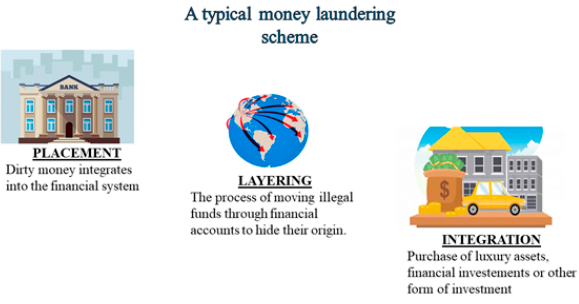
Figure 3. Money laundering stages. Source: own processing.